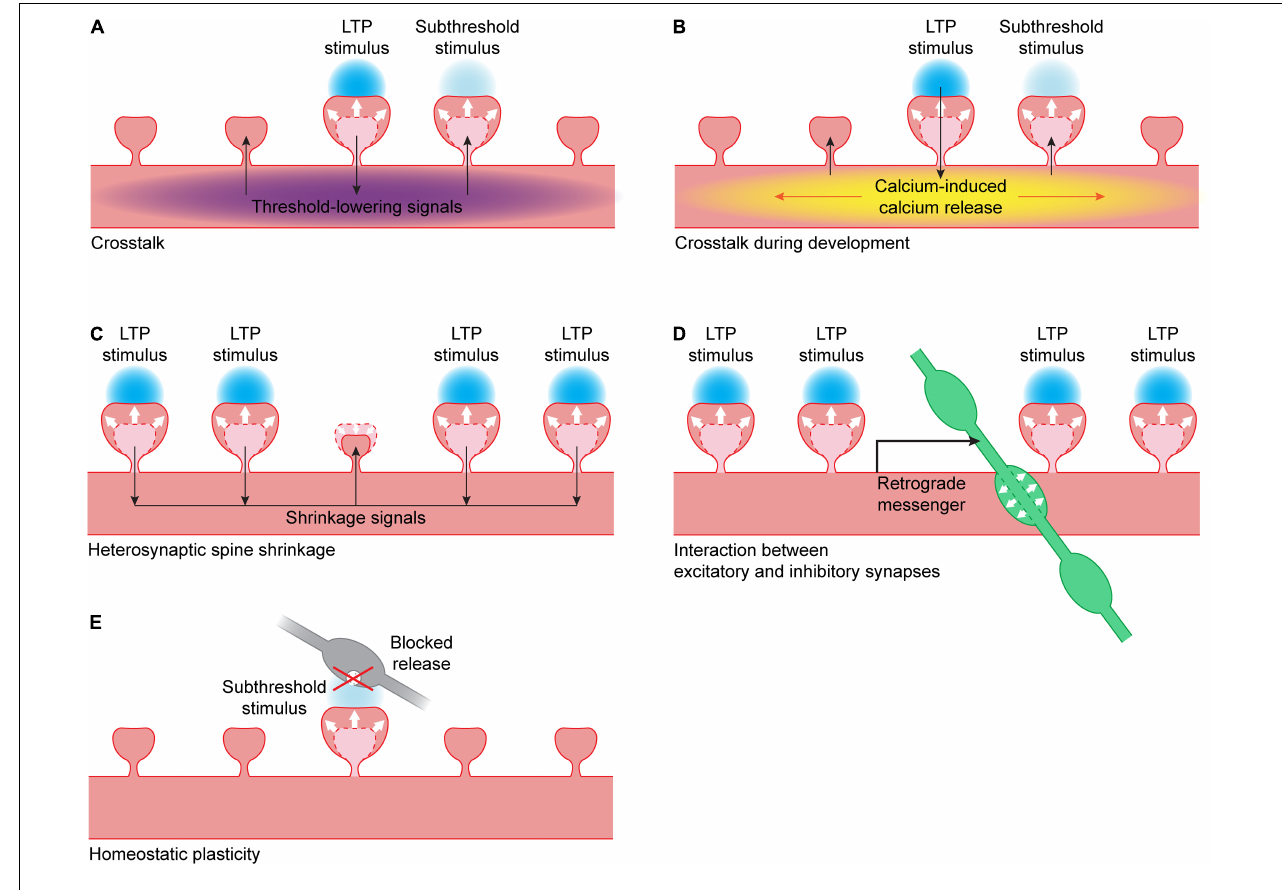
FIGURE 2 | Interactions between synapses. (A) When LTP is induced in a single spine using glutamate uncaging (blue), this leads to the spread of threshold-lowering signals (purple) in the dendrite. When a nearby spine receives a stimulus that is normally subthreshold, spine growth will occur. Threshold-lowering signals include the small GTPases Ras, Rac1 and RhoA (Harvey et al., 2008; Murakoshi et al., 2011; Hedrick et al., 2016) and BDNF-TrkB signaling (Harward et al., 2016; Colgan et al., 2018). PKA and ERK activity also spreads over the dendrite but it is unclear if these kinases are able to lower the LTP threshold (Zhai et al., 2013). (B) During development, the calcium influx in a single spine during glutamate uncaging can trigger calcium-induced calcium release (yellow). This leads to propagating calcium waves in the dendrite, and a nearby spine receiving a stimulus that is normally subthreshold will now show spine growth (Lee et al., 2016). (C) When a cluster of spines undergo LTP, this can lead to the activation of shrinkage signals. These signals can induce shrinkage of an unstimulated dendritic spine nearby (Oh et al., 2015). (D) When a cluster of spines undergo LTP, this can lead to the production of a retrograde messenger by the postsynaptic neuron. This messenger can trigger the growth of a presynaptic inhibitory bouton (green) nearby (Hu et al., 2019). (E) When vesicle fusion in the presynapse (gray) has been blocked for a prolonged period of time, this can lead to a lowering of the LTP threshold: when a spine receives a stimulus that is normally subthreshold, it will show spine growth (Lee et al.,